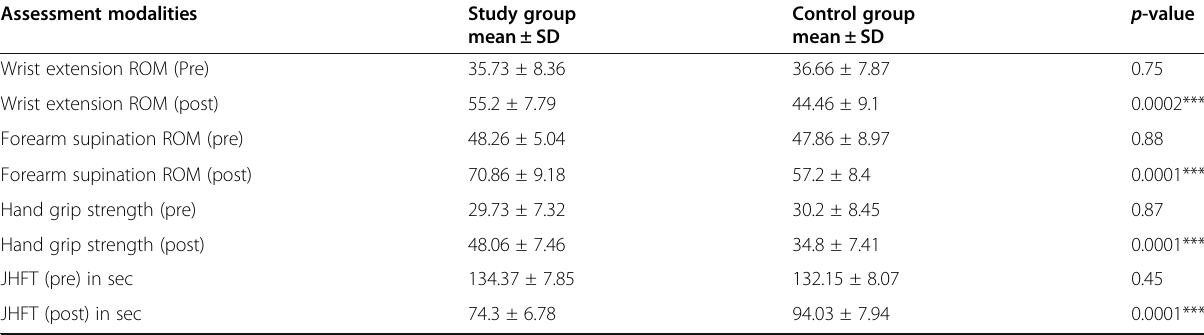
Table 1 It show comparison of pre and post treatment mean values of different assessment modalities between both groups Assessment